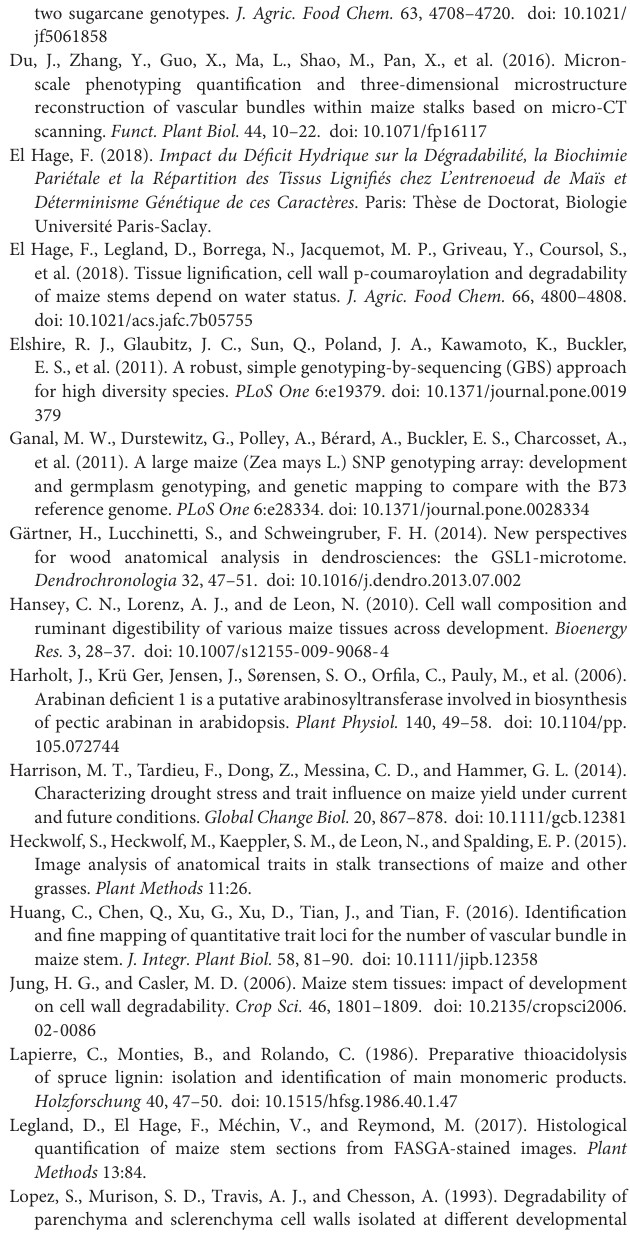
cultivated in 2014 and 2015 in both I and NI scenarios. Different letters reported for the parental values indicated significant differences from a Tukey test.